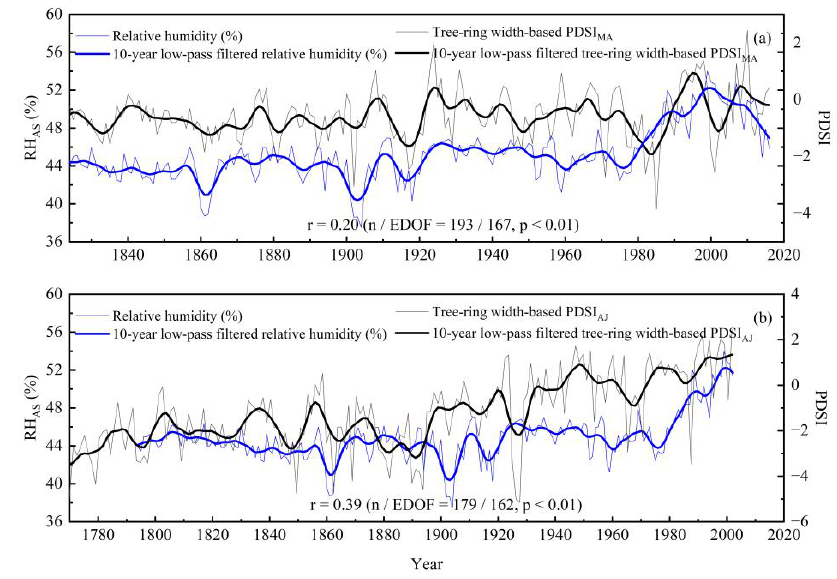
Figure 6. The comparisons between the reconstructed RH AS series (blue line) and ( a ) a tree-ring width-based PDSI MA reconstruction of the Hindu Kush mountains, Pakistan (black line) [68]. ( b ) A tree-ring width-based PDSI AJ reconstruction on the central Tien Shan mountains (black line) [69].